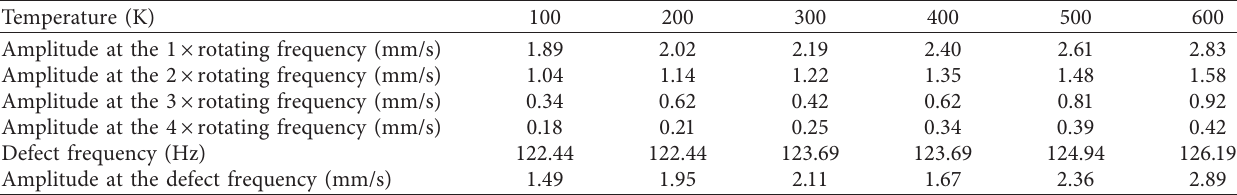
Figure 9: Frequency domain results for outer ring velocities. Table 4: Peak frequencies and amplitudes of the outer ring vibration in different temperatures.